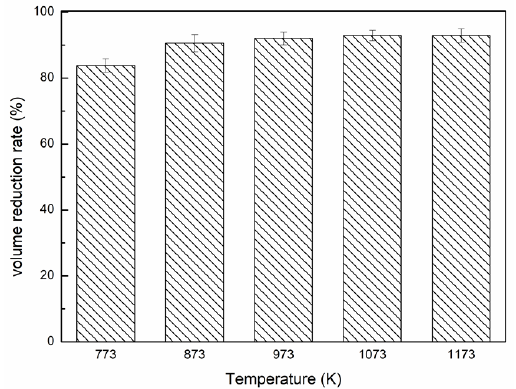
Figure 4. The effect of combustion temperature on the volume reduction rate.